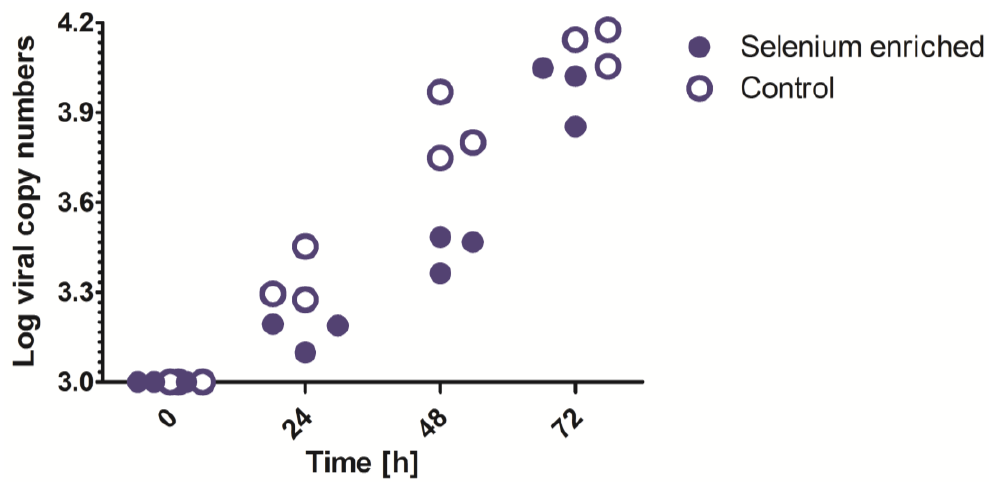
Figure 4. Viral copy numbers with or without the supplementation of selenium to cultured endothelial cells infected with Puumala hantavirus. Selenium supplementation (200 ng/mL of sodium selenite) to the culture medium leads to decreased viral replication after